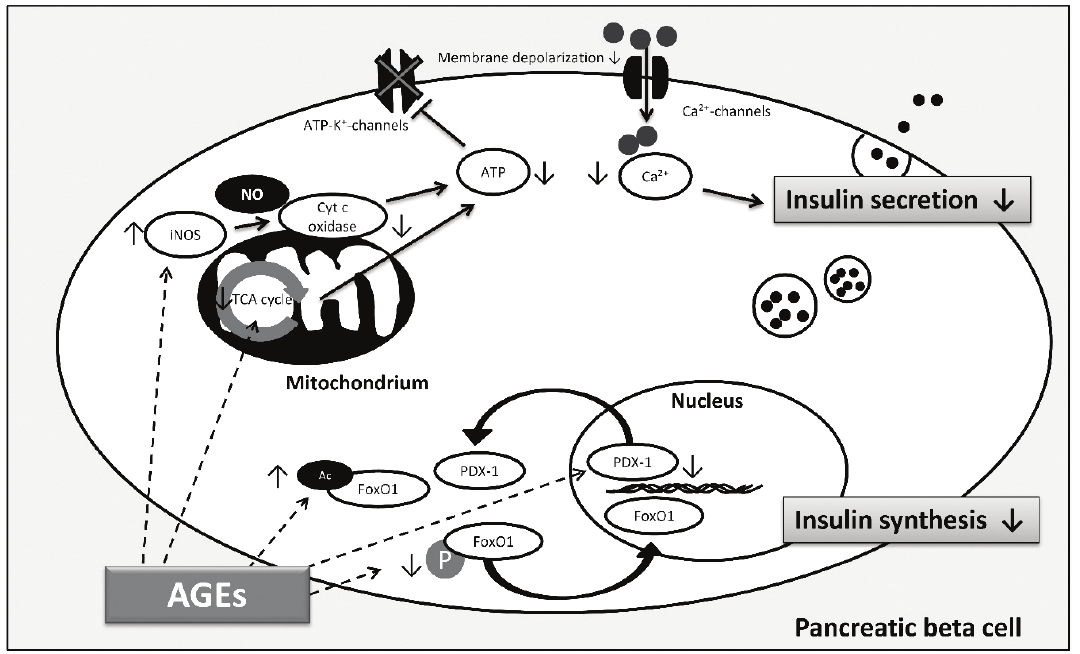
Figure 4. AGE-induced pathways involved in (cid:2) cell dysfunction according to [98,100,102,103]. Decreased insulin synthesis and reduced insulin secretion are both involved in (cid:2) cell failure contributing to hyperglycemia. AGEs reduce phosphorylation (P) and induce acetylation (Ac) of FoxO1, thus, FoxO1 translocates into the nucleus and is protected against proteasomal degradation, respectively. In addition, AGEs induce PDX-1 translocation into the cytoplasm and decrease PDX-1 protein expression, finally affecting insulin gene transcription and insulin synthesis. Regarding insulin secretion, AGEs cause inhibition by activation of iNOS and consequent blocking of cytochrome c oxidase activity and ATP depletion. Moreover, AGEs decrease insulin secretion through alterations in the TCA cycle which limits ATP production. ATP depletion inhibits closure of ATP-dependent potassium channels which leads to reduced membrane depolarization and decrease of intracellular calcium concentration inhibiting insulin secretion. (Arrows illustrate direct interactions; dashed arrows illustrate possible targets of